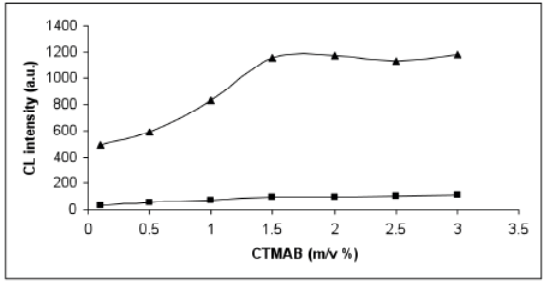
Figure 4. The effect of CTMAB concentration (reagent 1) in the absence ( ■ ) and in the presence ( ▲ ) of 40 mg L -1 PVK. Reagent